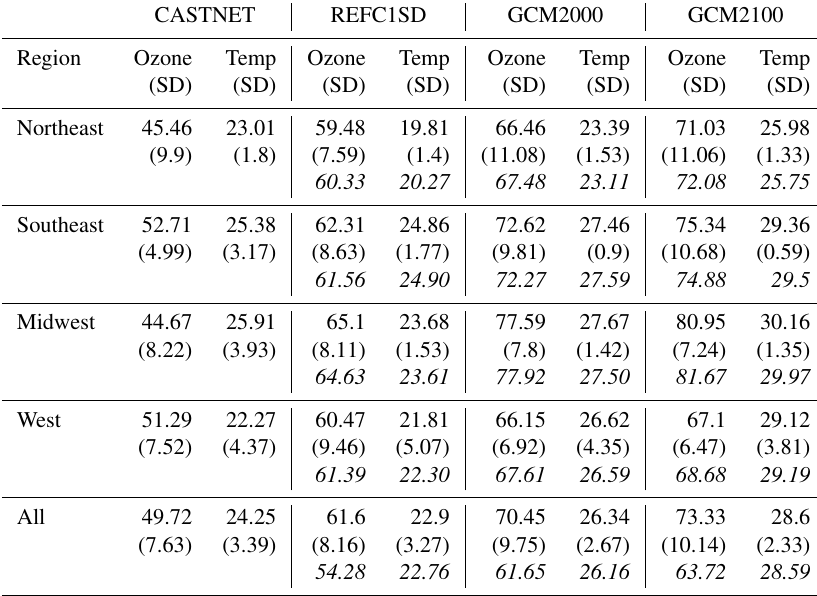
Table 2. Rescaled data. MDA8 ozone averages (ppb) and daily maximum temperature averages ( ◦ C) in different regions over the US from CASTNET data and corresponding grid points from the CESM1 REFC1SD, the GCM2000 and the GCM2100 simulations. The averages are calculated from MDA8 (for ozone) and daily maximum (for temperature). Standard deviation (SD) is calculated among the stations in each region. The averages of ozone and temperature from each region are reported in italics (including all continental grid points in each box in Fig. 2a). The italics under “All” are averages of all points over the continental